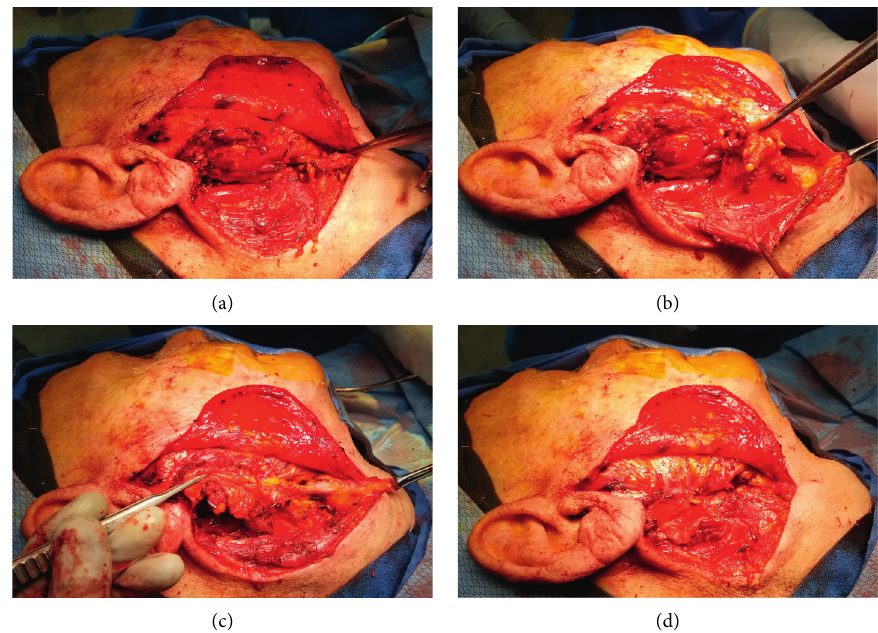
Figure 1: Volume reconstruction using pedicled lymphoadipose tissue after superficial parotidectomy. (a) Volume defect present after superficial parotidectomy. (b) Level I and II lymphoadipose tissue freed from surrounding structures with preservation of pedicle containing vascular supply. (c) Lymphoadipose tissue rotated posteriorly and superiorly into parotid defect. (d) Lymphoadipose tissue secured to parotid